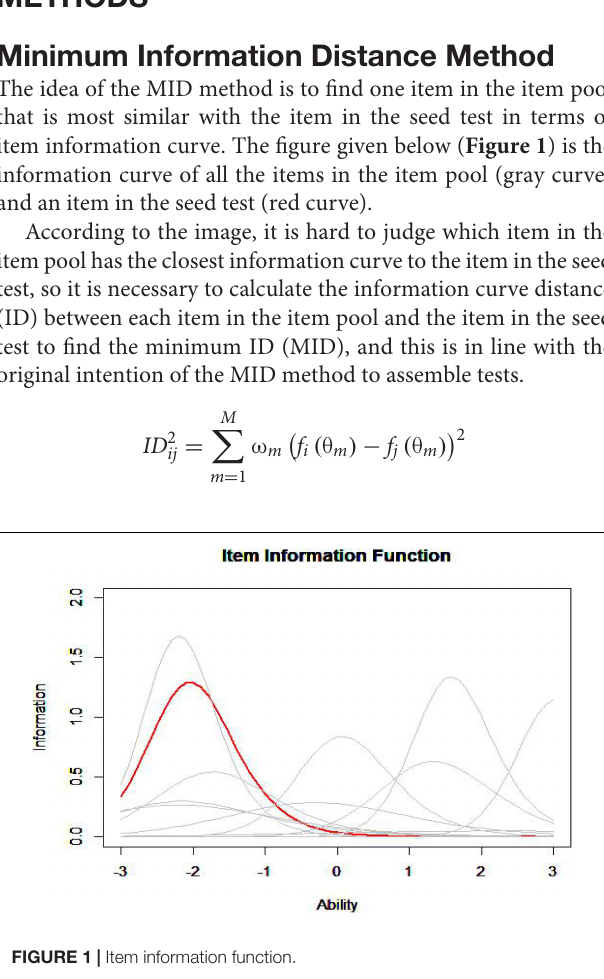
FIGURE 1 | Item information